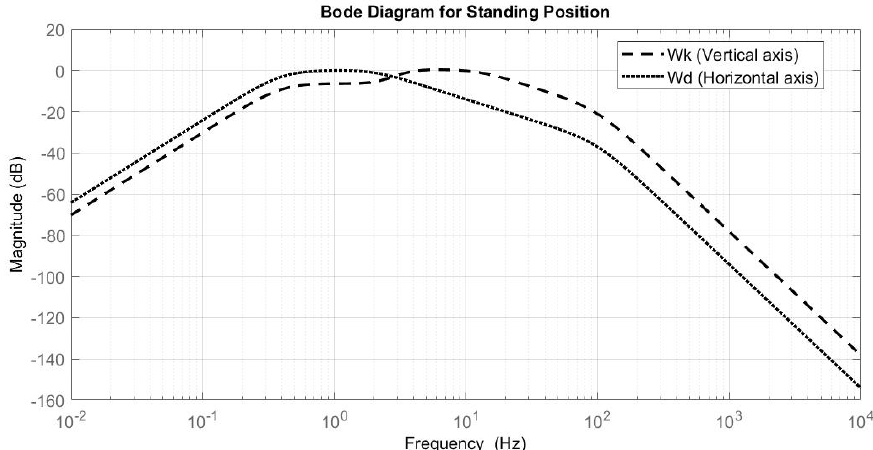
Figure 4. Bode diagrams for horizontal and vertical transference functions.